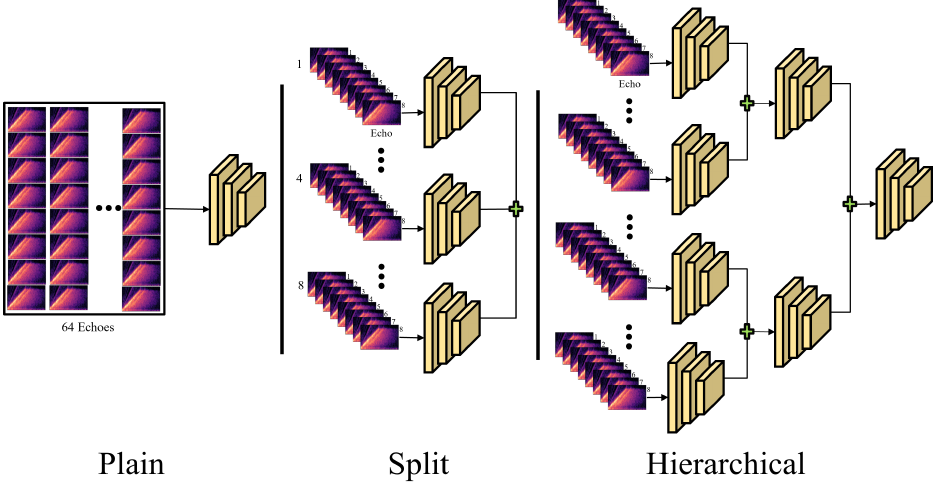
Figure 8. Encoder architecture